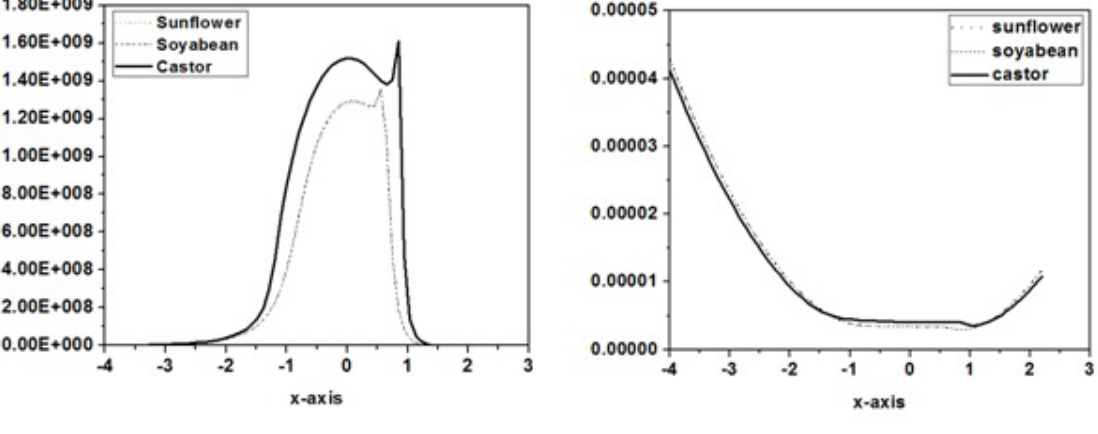
Fig. 3 EHL pressure and film thickness profile for all tested oils. U = 1 . 0 × 10 − 11 and W = 2 . 0452 × 10 − 5